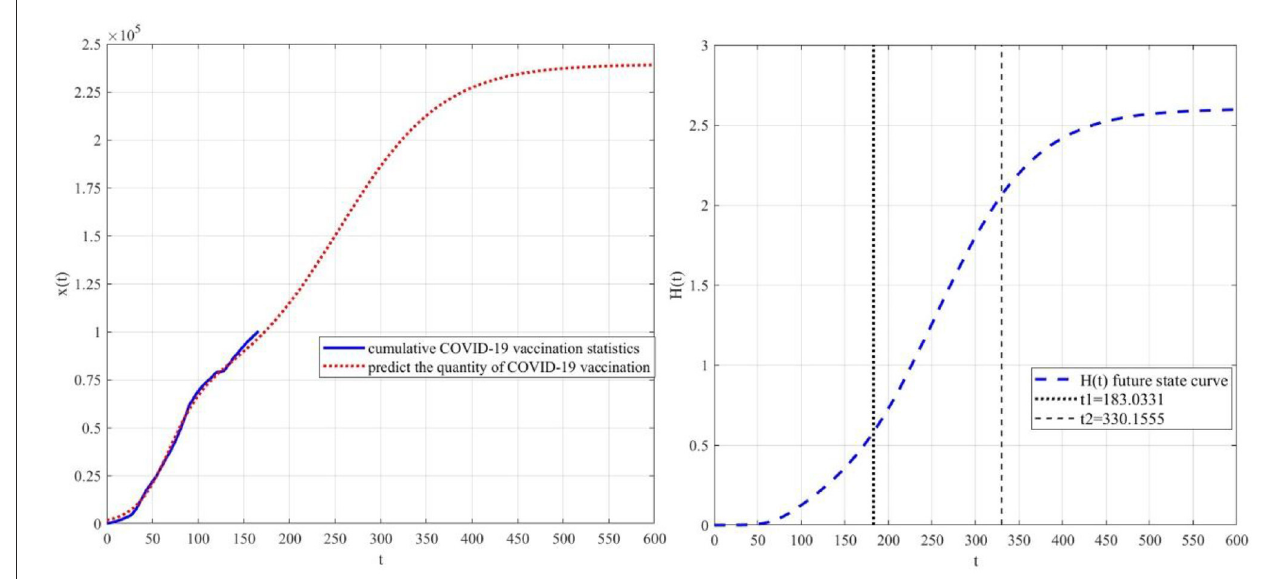
FIGURE14 Prediction based on the fourth stage.